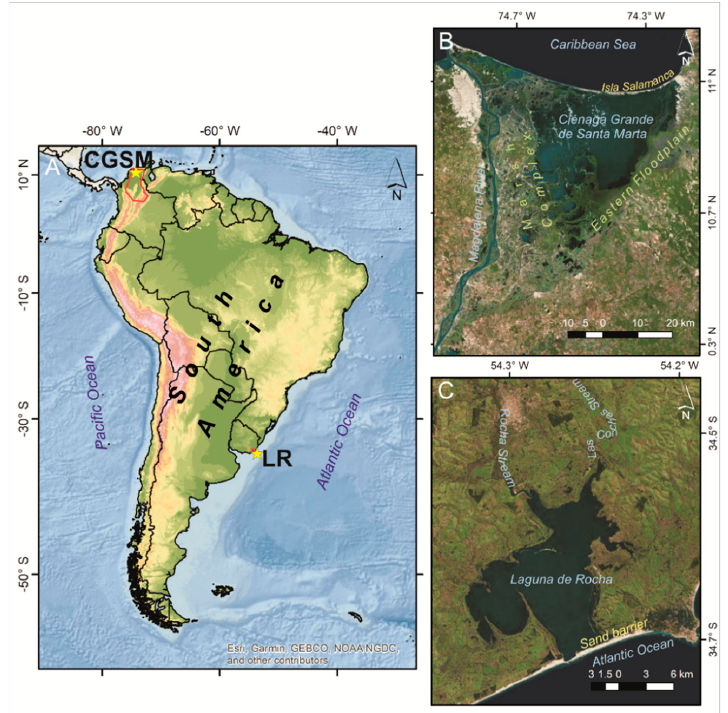
Figure 2. Location of the study sites and hydrological connections. ( A ) Location of the study sites circled in red in respect to South America. ( B ) The Ciénaga Grande de Santa Marta Lagoon in Colombia, the Caribbean, sand barrier (Isla de Salamanca) and the Magdalena River (see text for more detail). ( C ) La Rocha Lagoon in Uruguay, the Atlantic Ocean, sand barrier and main tributaries (see text for more detail).